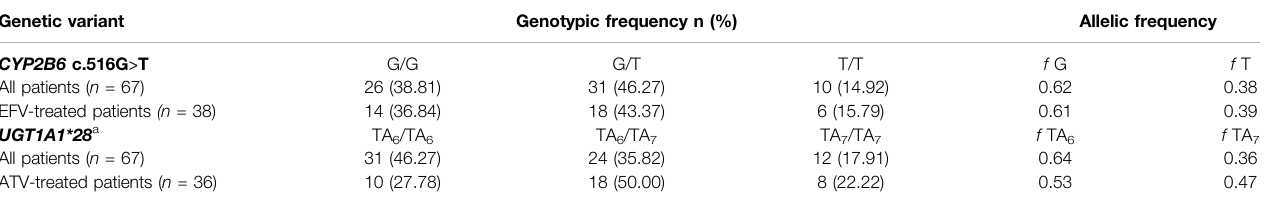
TABLE 3 | Genotype and allele frequencies in patients recruited for this study. Genetic variant